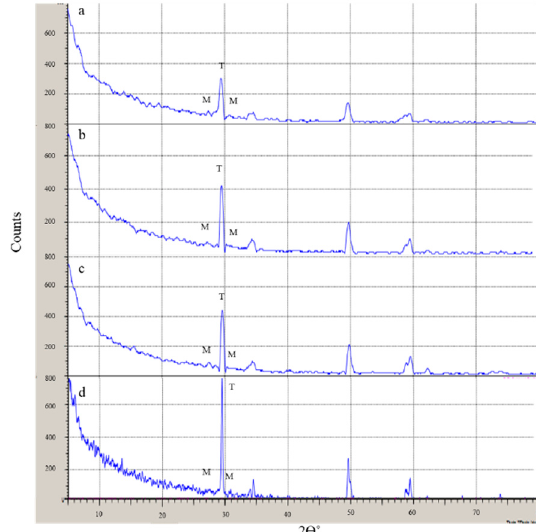
Figure 8. XRD diffraction pattern for all studied groups; ( a ) CoJet, ( b ) FGC, ( c ) FGC+ Nd: Laser, and ( d ) Control. Relative intensities of tetragonal and monoclinic peaks were marked at I T (101) and I M (111 and 111 − ) by letters T and M, respectively.